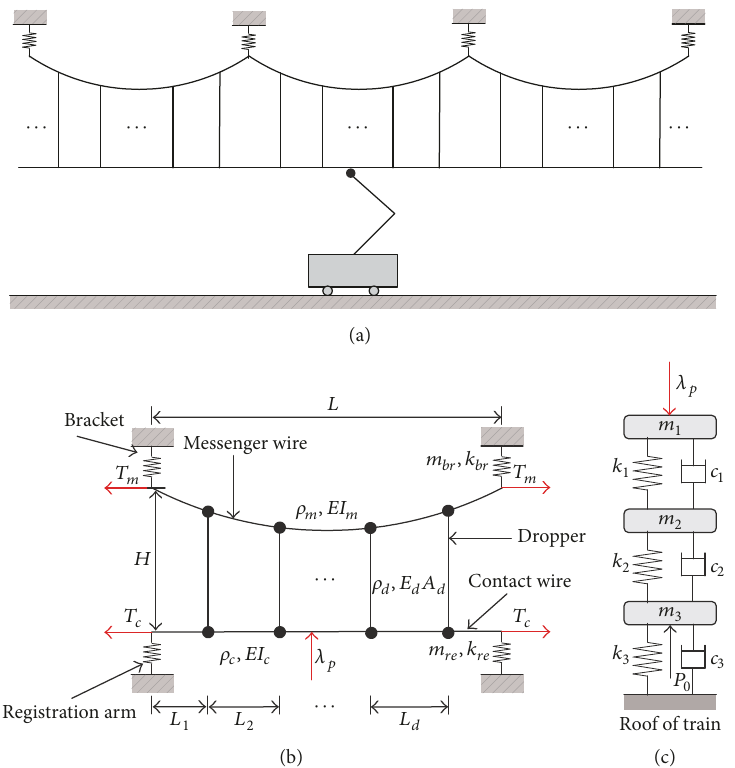
Figure 2: The model of the pantograph-catenary system: (a) the pantograph-catenary system, (b) a unit cell of the catenary, and (c) the